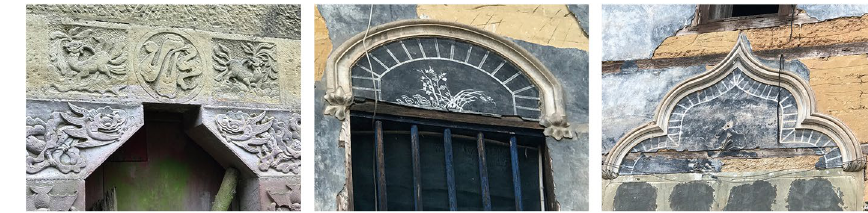
Fig. 8 Watchtower house door and windows with a Western-style decorative pattern in Chongqing (Source: the